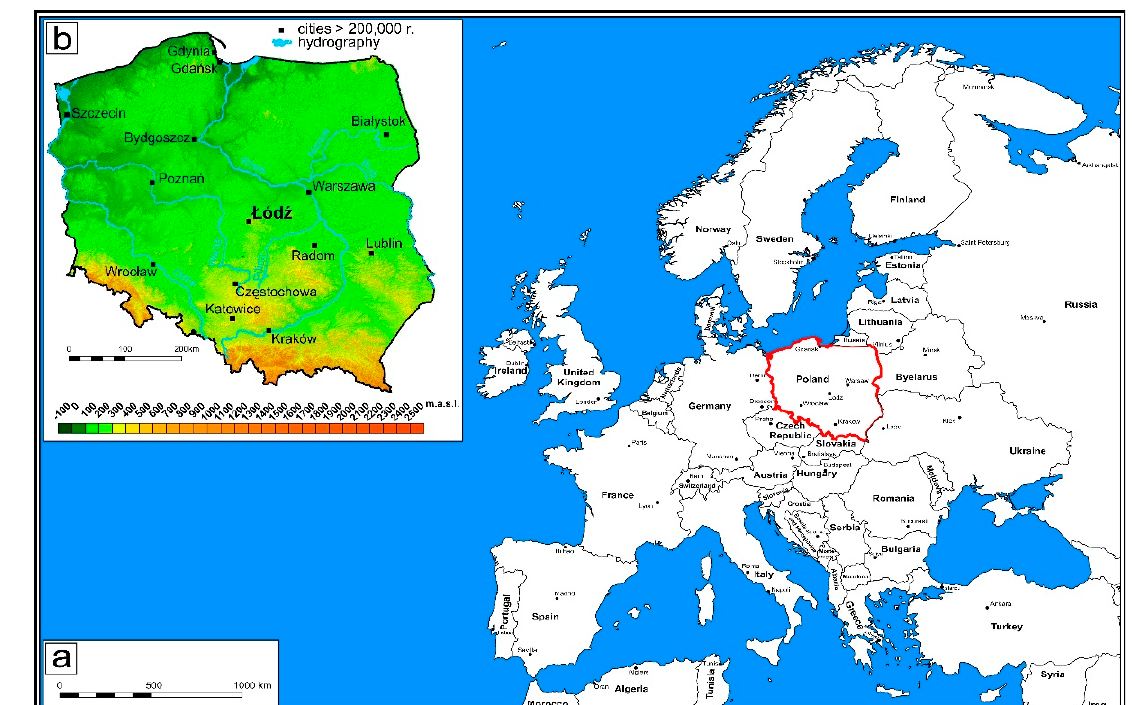
Figure 1. Location of the study area in Europe ( a ) and Poland ( b ). Source: Own elaboration based on GUGiK and Golden Software data.